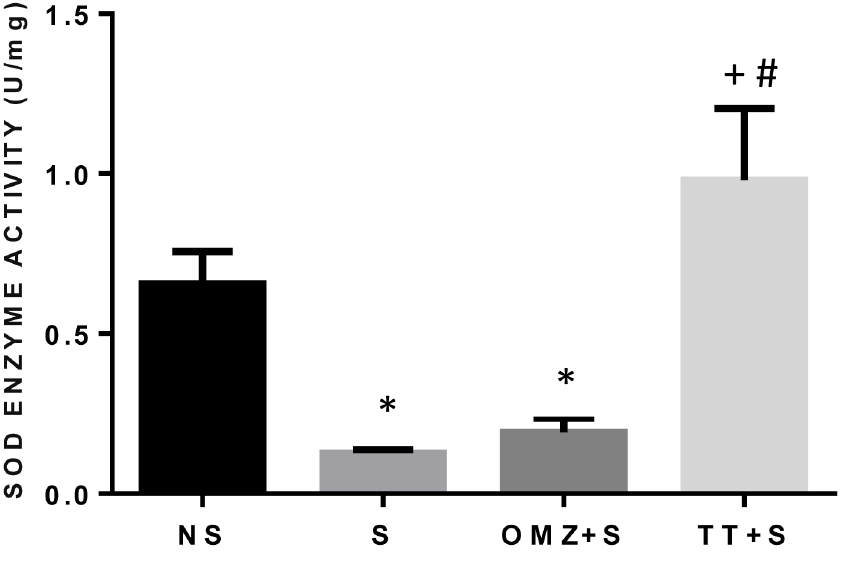
Fig 4. Effects of pre-treatment with tocotrienol (60 mg/kg BW) (TT) or omeprazole (20 mg/kg BW) (OMZ) on gastric SOD enzyme activity in rats exposed to water immersion restraint stress (n = 7). * vs non-stressed control (NS) (P < 0.05). + vs stressed control (S) (P < 0.05). # vs omeprazole (OMZ) (P < 0.05).